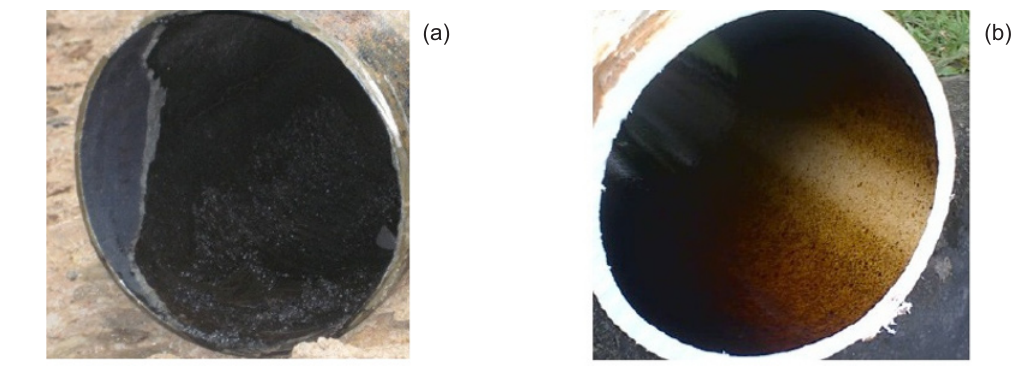
Figure 7. Photographs of scales in steel pipe before (a)) and after (b)) the EGD was